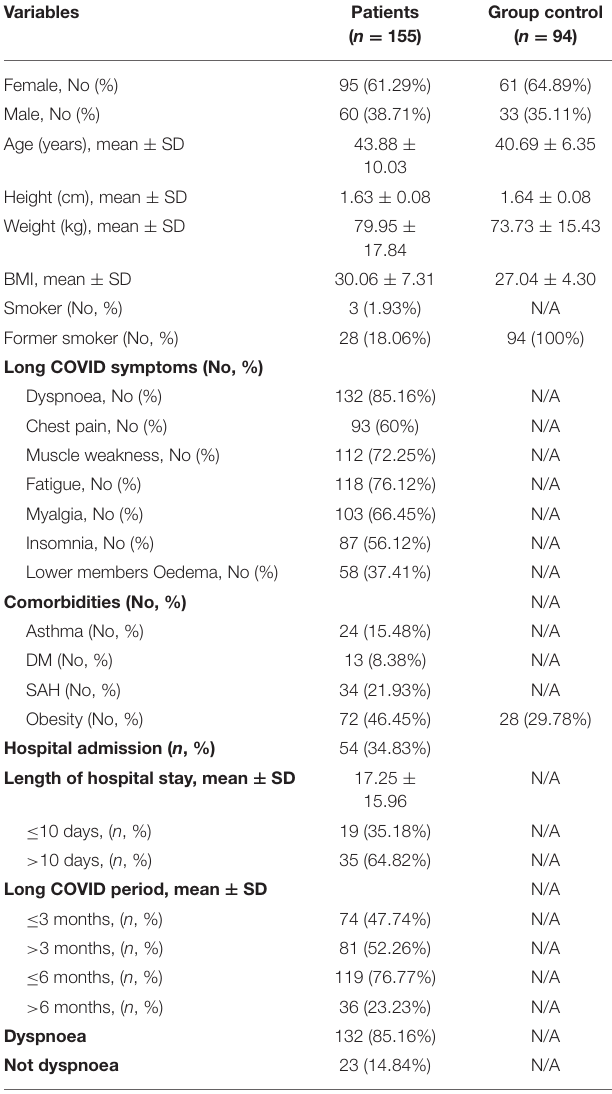
TABLE 1 | Demographic characteristics and comorbidities of the study population and symptoms of long COVID.